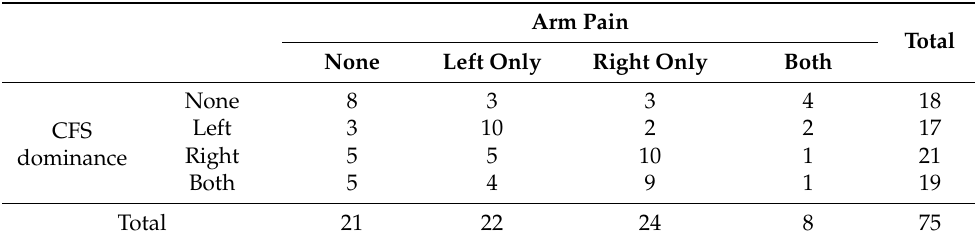
Table 2. Distribution of CFS dominance divided by total counts of CFS ≥ grade 2 on left and right sides and arm pain sidedness.